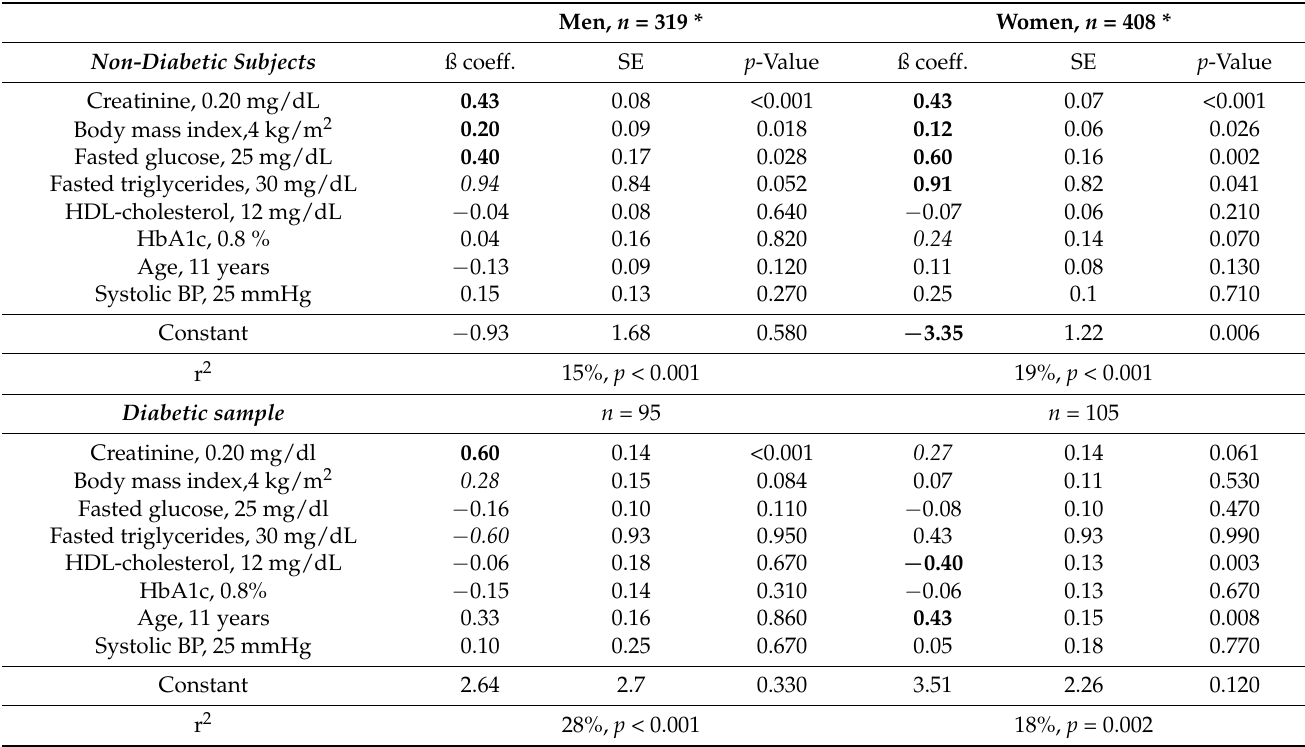
Table 2. Linear regression analysis for independent associations with baseline serum uric acid (SUA) ( n =927), stratified by diabetic status and